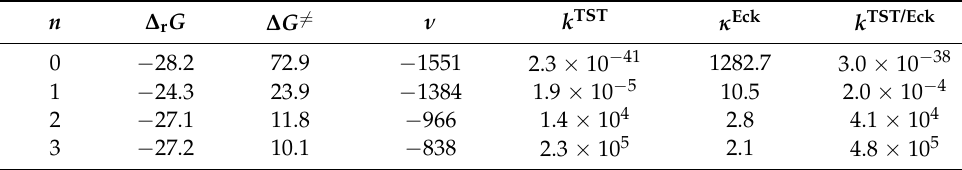
Table 2. Number of water molecules n , reaction Gibbs free energy ∆ r G (kcal/mol), activation Gibbs free energy ∆ G (cid:54) = (kcal/mol), imaginary frequency ν (cm − 1 ), Eckart tunneling coefficient κ Eck , k TST , and k TST/Eck rate constant (s − 1 ) at 298.15